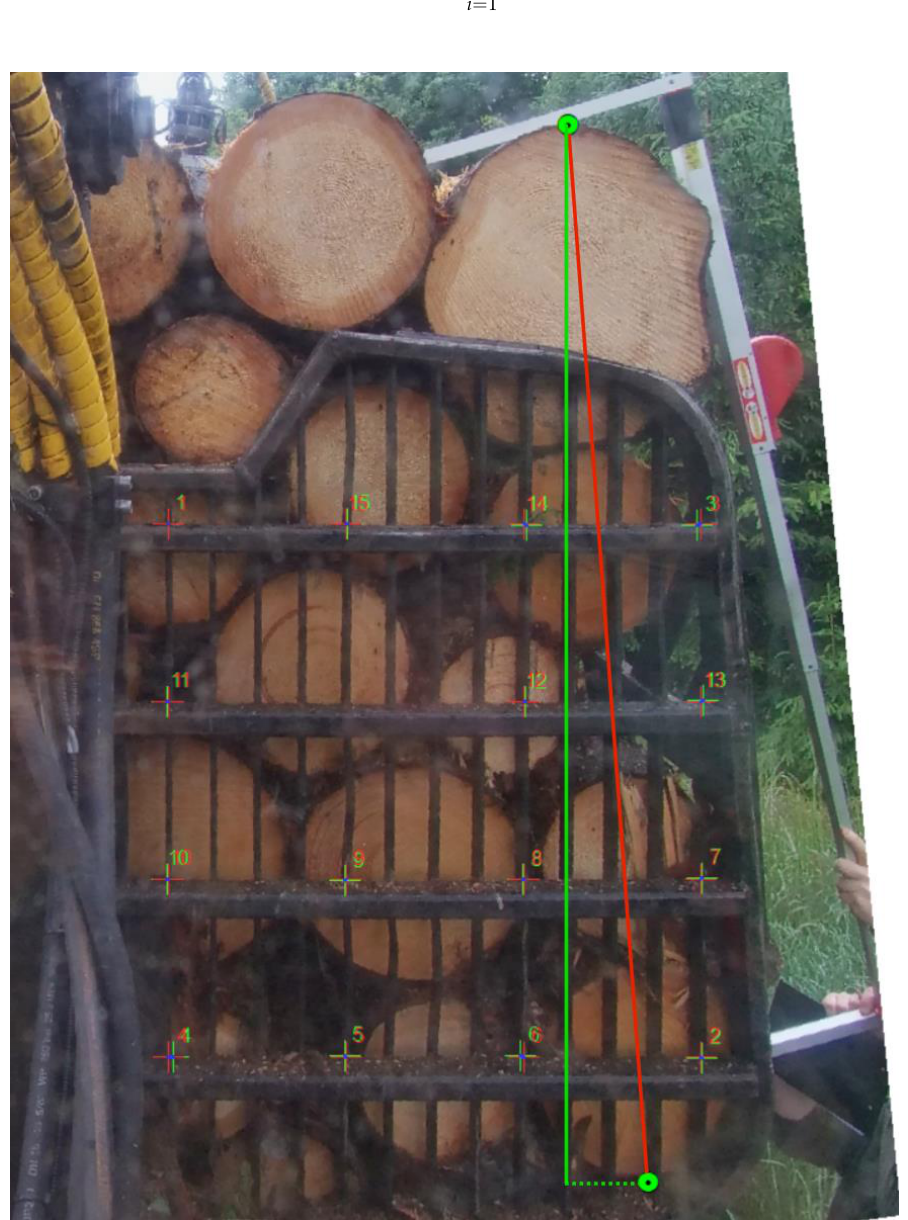
Figure 2. Rectification pattern with calibrated points and points indicating the measured top and bottom of the load on the side. The red line indicates the straight-line distance and distance measured by Telefix measuring gauge, and the green line represents vertical distance derived from the rectified images.